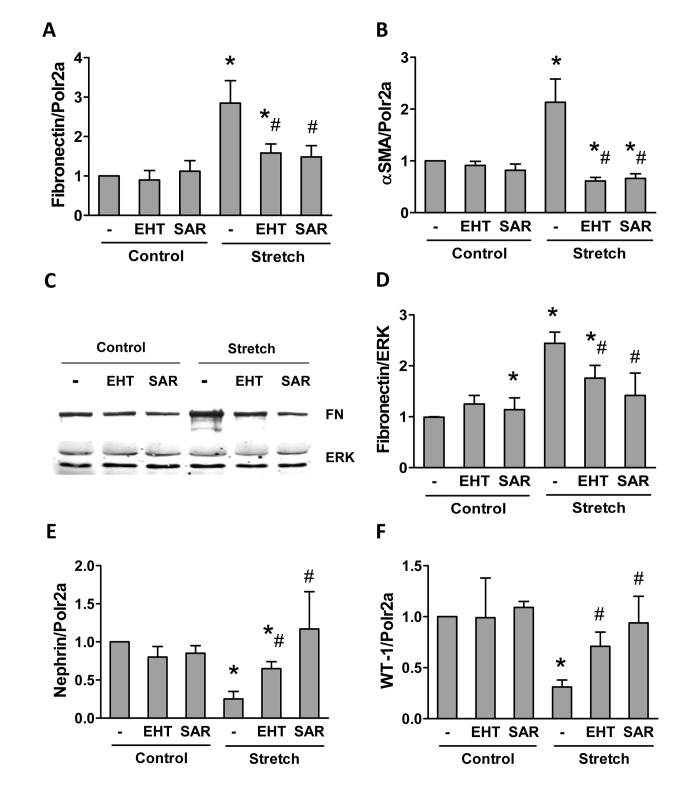
Stretch-induced signaling is sensitive to GTPase inhibition.Effect of stretch (24hours) on podocytes in the presence or absence of EHT (1µM) or SAR (1µM) on fibronectin mRNA expression (A), α-smooth muscle actin mRNA expression (B) fibronectin protein expression (C&D) and nephrin and WT-1 mRNA expression (E&F). ERK was used as reference for protein expression, polymerase 2a (Polr2a) as housekeeping gene for mRNA expression. Data represent the mean ± SEM of three independent experiments. *P<0.05 vs. corresponding non-stretched control; # P<0.05 vs. stretched control.